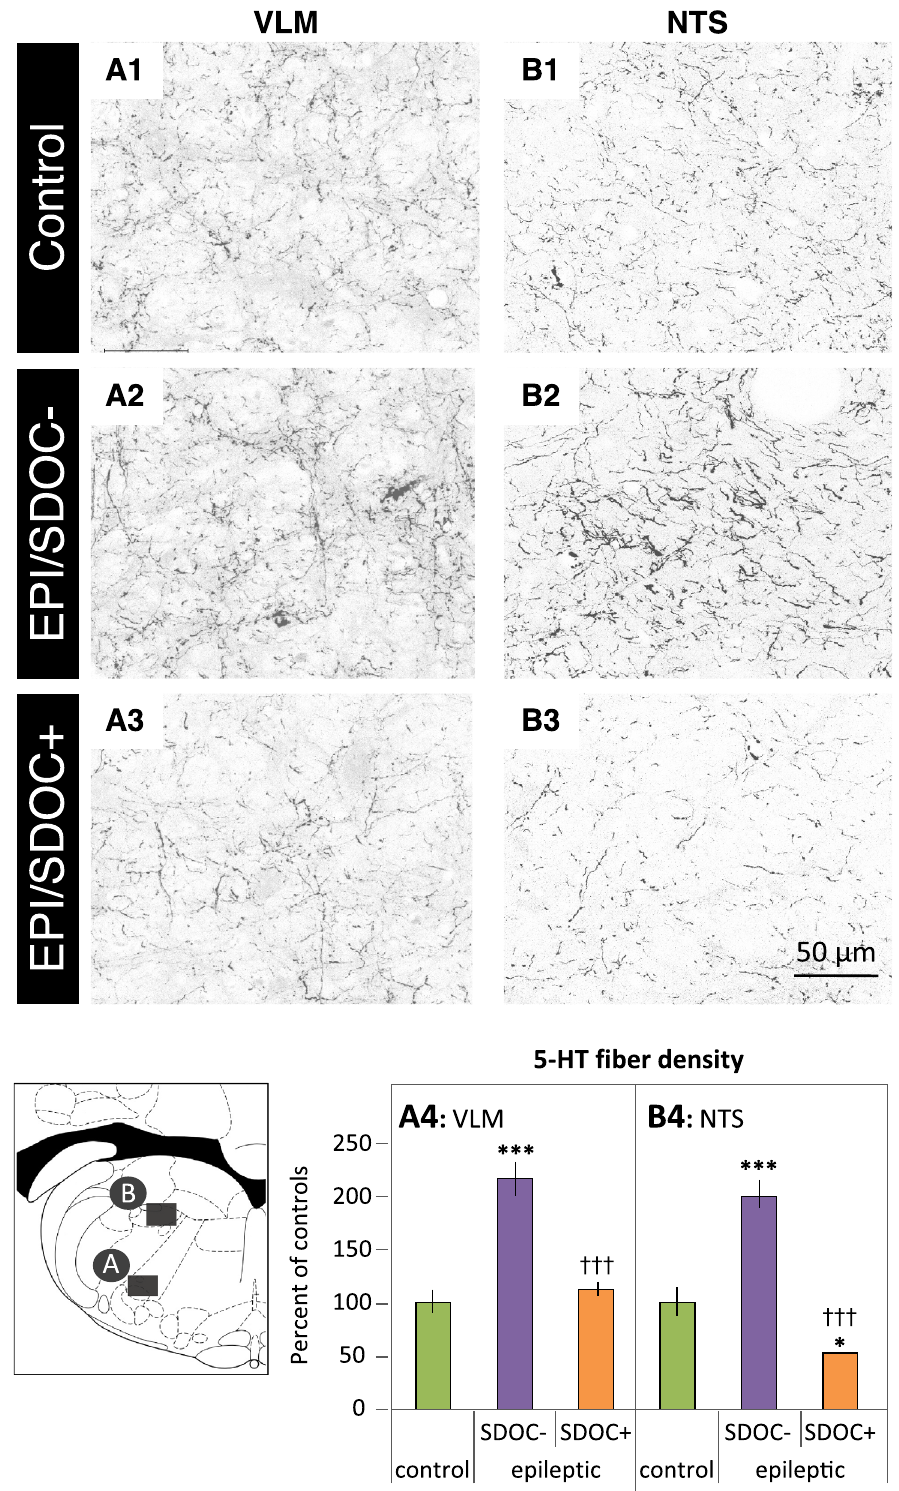
Figure 4. Semi-quantification of 5-HT immunopositive terminals in the caudal raphe nuclei within the medulla oblongata in control and EPI rats. Fluorescent 5-HT labeling was performed in sections selected at interaural − 2.60 mm within two brainstem regions involved in the regulation of respiratory rhythm generation: the ventrolateral medulla (VLM) and nucleus tractus solitarius (NTS). Images of 5-HT positive fibers were captured within the VLM (A1, A2, A3) and the NTS (B1, B2, B3) using confocal microscopy (× 63 objective). Density of 5-HT positive fibers was calculated in the VLM (A4) and the NTS (B4). Data are expressed as mean ± SEM (n = 3 per group). *P < 0.05; ***P < 0.001, compared to controls and †††P < 0.001, compared to EPI/